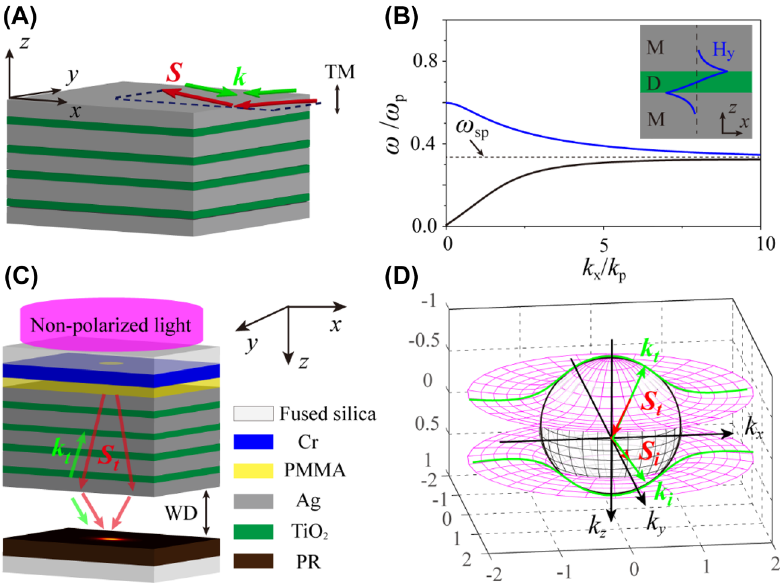
Figure1: DesignofaNIMforphotolithography. (A) Schematic of plasmonic waveguide- based NIM multilayer. The dashed lines indicate the incident plane of a TM-polarized light parallels to the layers. Red and green – blue arrows depict the directions of S and k , respectively. (B) Dispersion relations for modesinanMDMwaveguidewith h d =19 nm and ε d = 8.52, where k p = ω p / c . The corre- sponding structure and magnetic fi eld dis- tribution Hy along the z axis are shown in the inset. (C) Schematic of the NIM-based lithography design. (D) Three-dimensional plots of EFCs for the plane wave with a wavelength of 365 nm in NIM slab and in free space. S i and S t show the incident and transmitted time-averaged Poynting vectors, respectively; k i and k t give the incident and transmitted wavevectors,